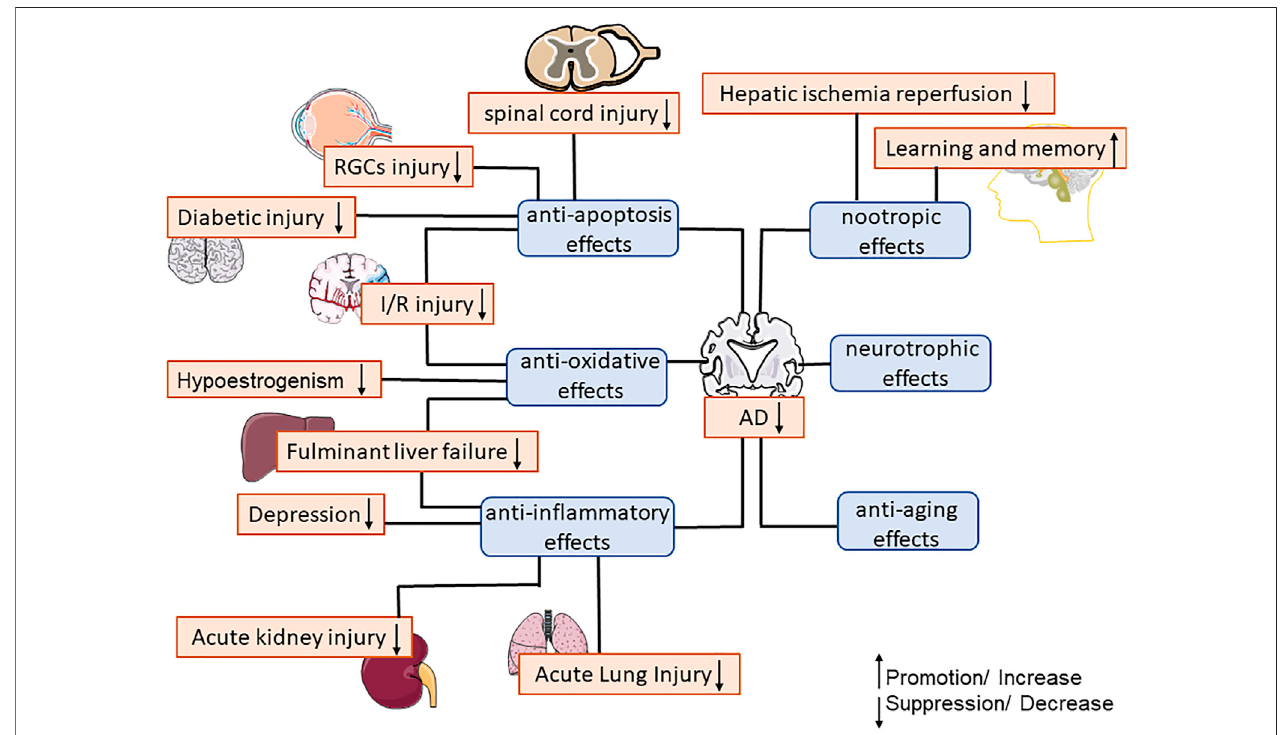
FIGURE 3 | The main pharmacological activities of